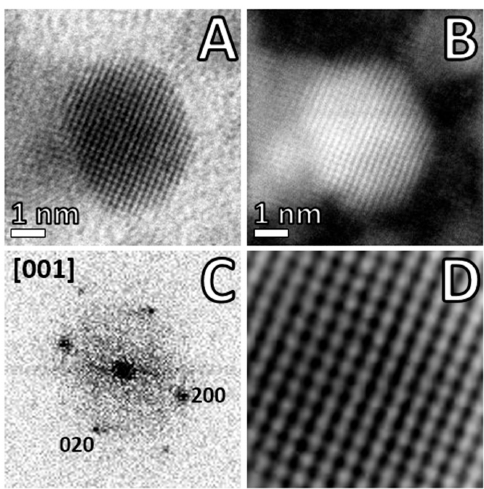
Figure 5. Atomic resolution Cs ‐ STEM imaging. ( A ) BF ‐ STEM imaging. ( B ) HAADF ‐ STEM imaging. ( C ) FFT pattern. ( D ) Detail of palladium nanoparticle with crystalline arrangement. Imaging with JEM ARM ‐ 200F (JEOL), operated at an accelerating voltage of 80 kV in STEM mode.